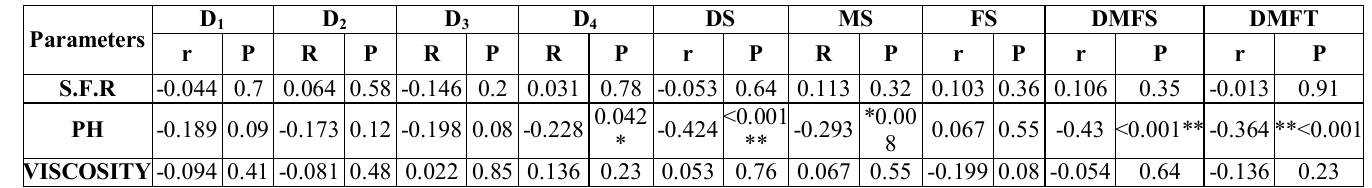
Table 5: Relation of dental caries with salivary physicochemical characteristic for pregnant women.